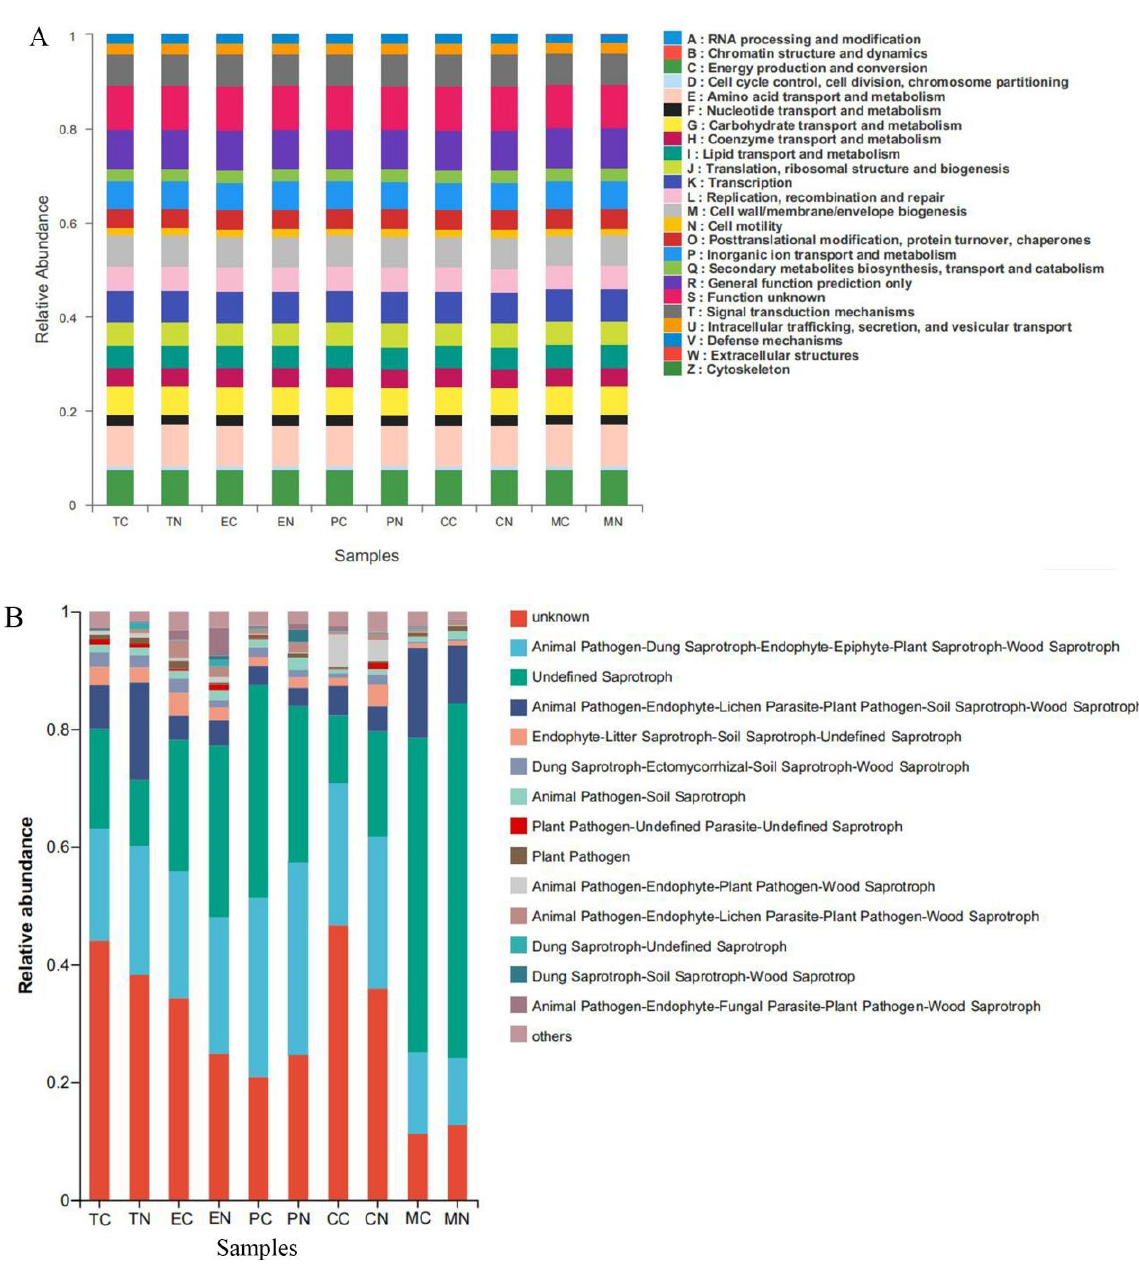
Figure 6. Predicted relative abundances of functional gene for bacteria and fungi by PICRUSt and FUNGild. ( A ) Bacteria; ( B ) Fungi. TC, tomato-CK; TN, tomato-NCD-2; EC, eggplant-CK; EN, egg-plant-NCD-2; PC, pepper-CK; PN, pepper-NCD-2; CC, cotton-CK; CN, cotton-NCD-2; MC, maize-CK; MN, maize-NCD-2.